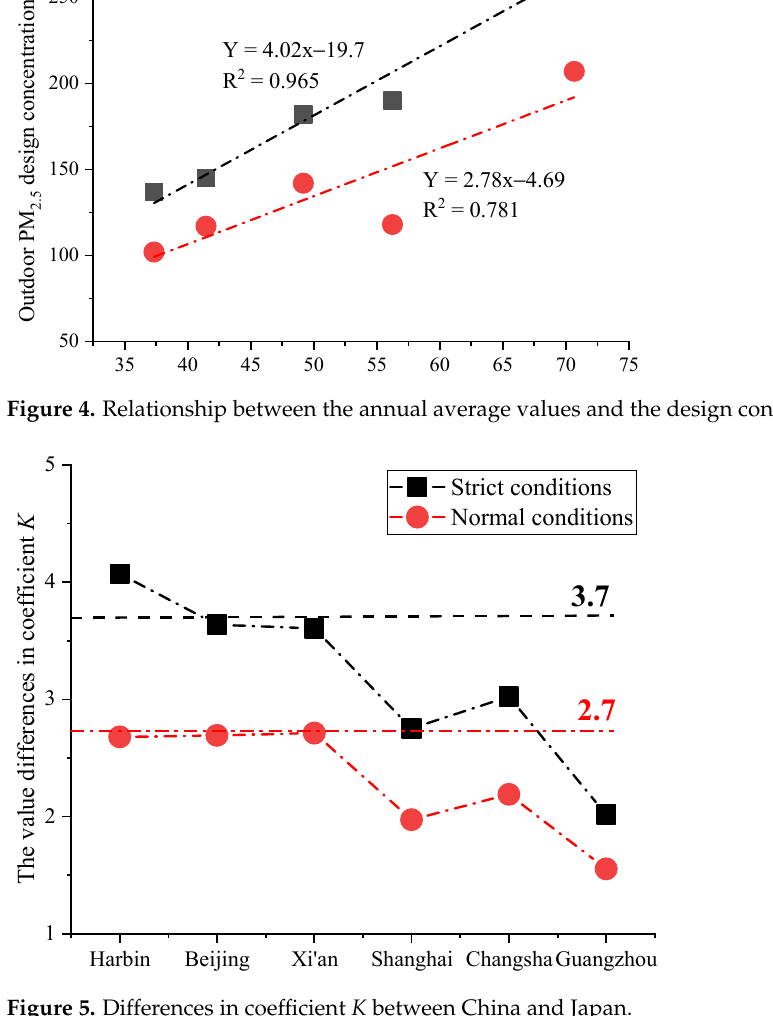
Figure 5. Differences in coefficient K between China and Japan. Table 4. The recommended coefficient K values for six typical cities from 2016 to 2020. City